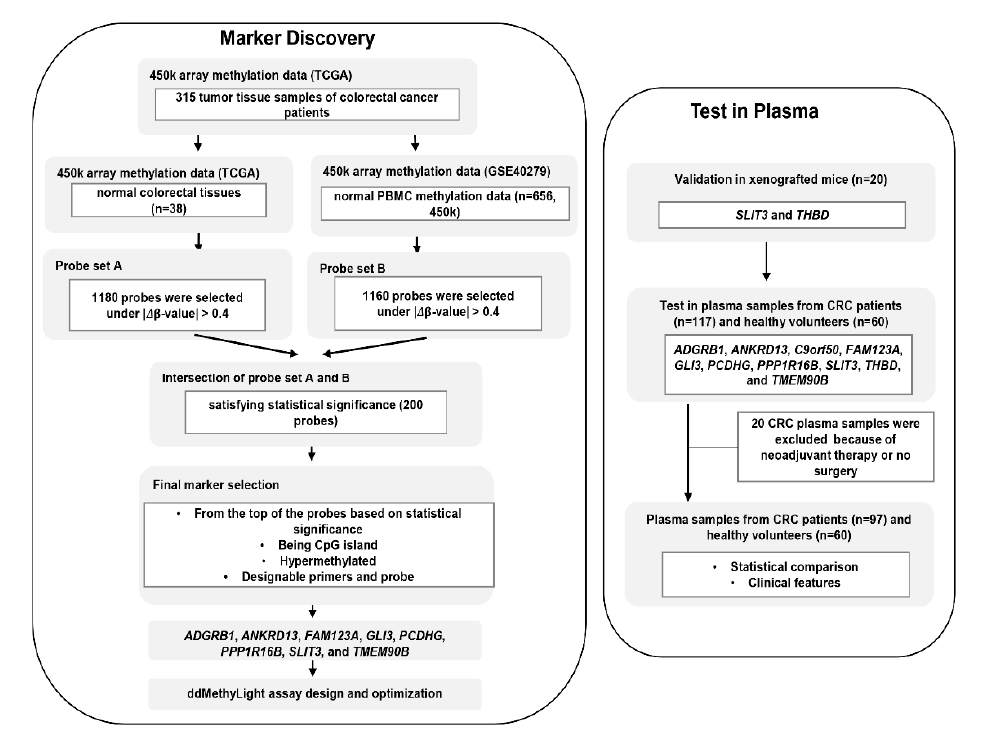
Figure 1. Overview of study workflow from marker discovery to verification in plasma samples. The process of selection of candidate DNA methylation markers and their verification in detection of colorectal cancer (CRC) in cell-free DNA (cfDNA) samples from patients with CRC were schematically represented.